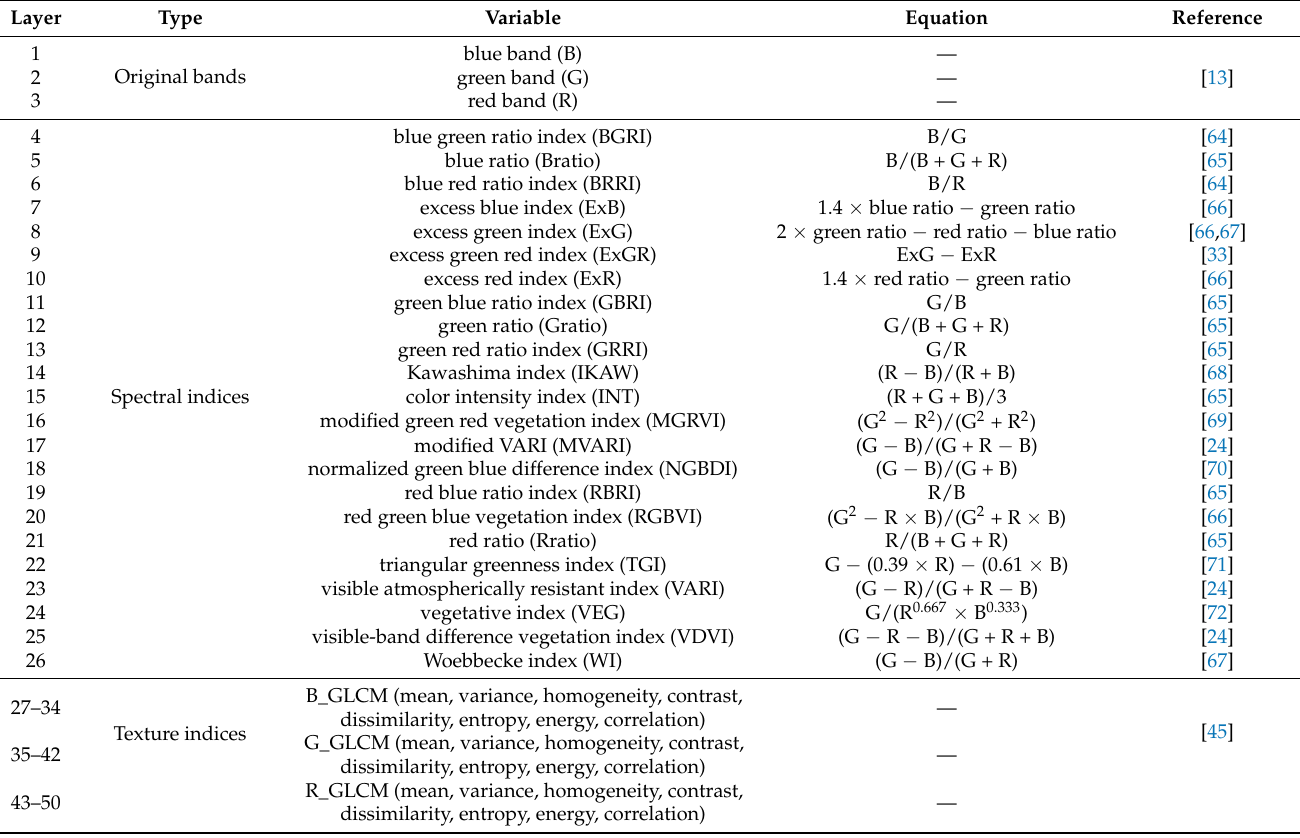
Table A3. The unmanned aerial vehicle (UAV) image data and variables derived from the